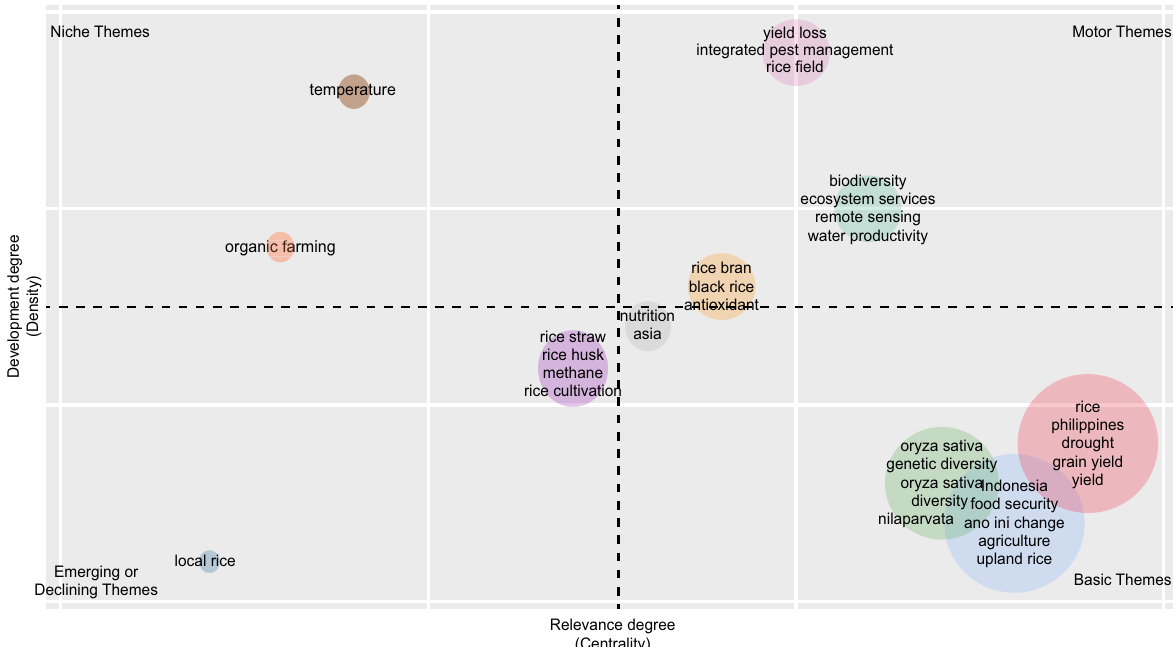
Fig. 11 Knowledge Hotspots of rice research in Indonesia and the Philippines since 2001. There are four major themes composed of 11 clusters of rice research in Indonesia and the Philippines since